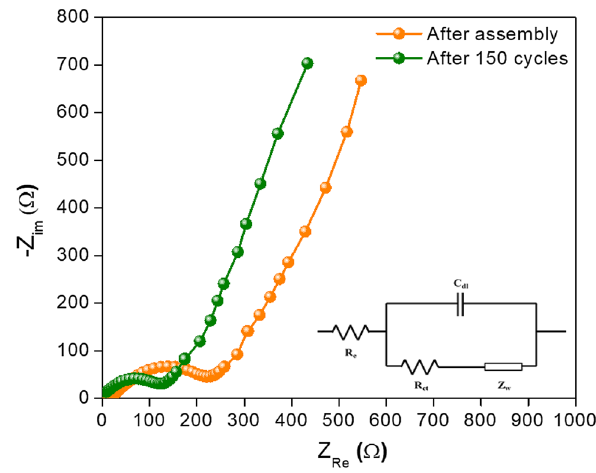
Fig. 11 Nyquist plots of B-TiO